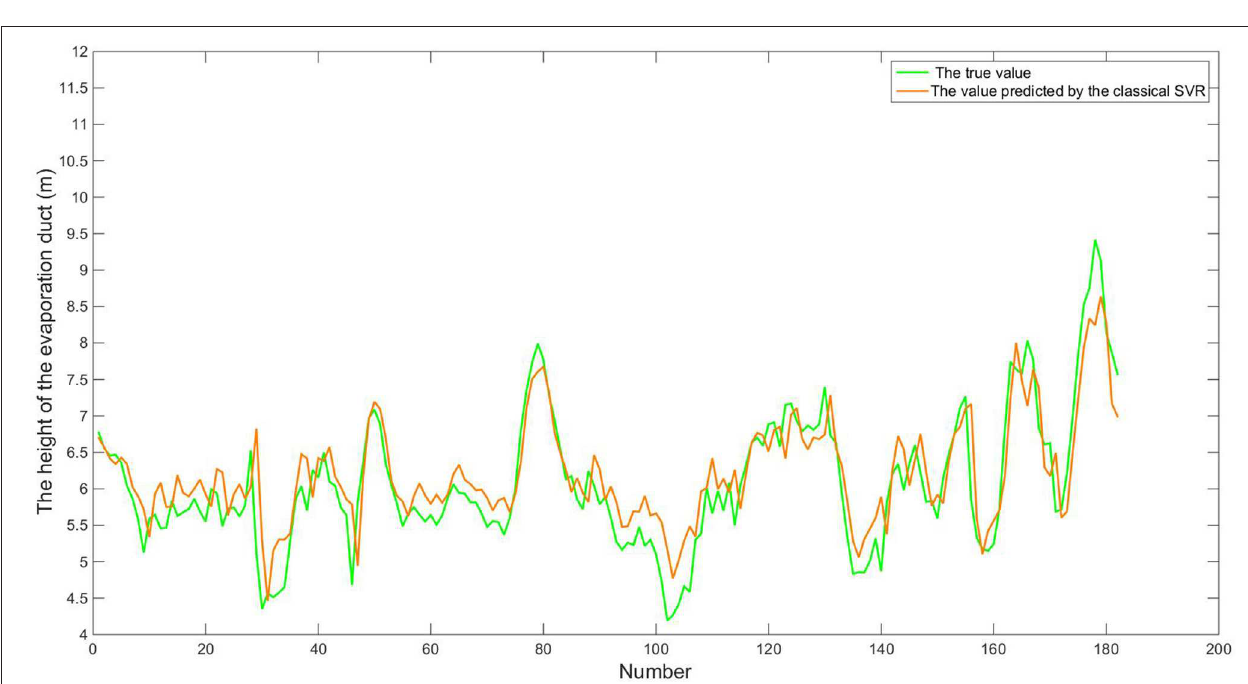
Figures 9 , 10 show the individual RMSEs and MAPEs of the last quarter of time series X ′ , using the three prediction algorithms. Table 7 shows the corresponding overall RMSE and MAPE